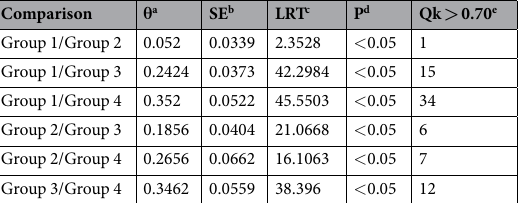
Table 4. Functional divergence estimated between CDPK subfamilies. a θ is the coefficient of type I functional divergence between two groups. b SE: standard error. c LRT is a likelihood ratio test. d The significance level (P value) is computed using Fisher’s transformation. e N (0.7) indicate the number of divergent residues when the cut-off value was 0.7.